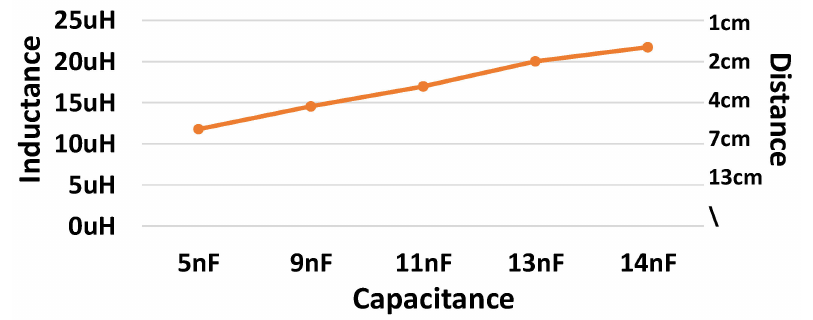
Figure 28. The curve of the distance of the coupled coil, after five groups of auxiliary capacitors are connected in